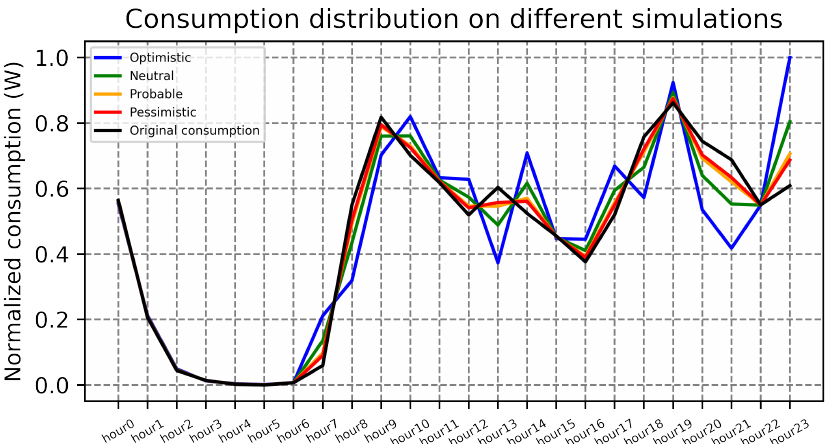
Figure 12. Consumption distribution on the different